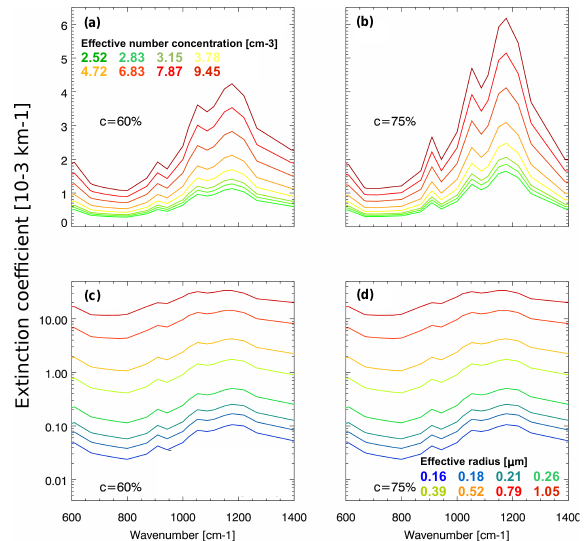
Figure 3. Spectral extinction coefficient for a sulfate aerosol layer, as a function of (a, b) the effective number concentration N e (different number concentrations in different colours; see colour- coded legend) (c, d) the effective radius r e (different radii in differ- ent colours, see colour-coded legend). Sulfate aerosol layers with 60 and 75% (values indicated in the plots) H 2 SO 4 mixing ratios are considered at 213–215K. Please note the logarithmic ordinate in (c, d)